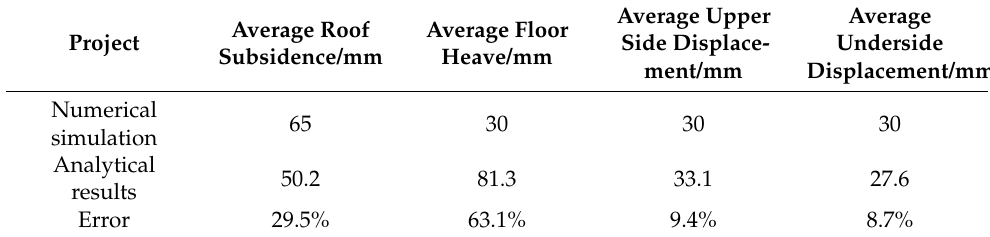
Table 4. Comparison of numerical and analytical results.